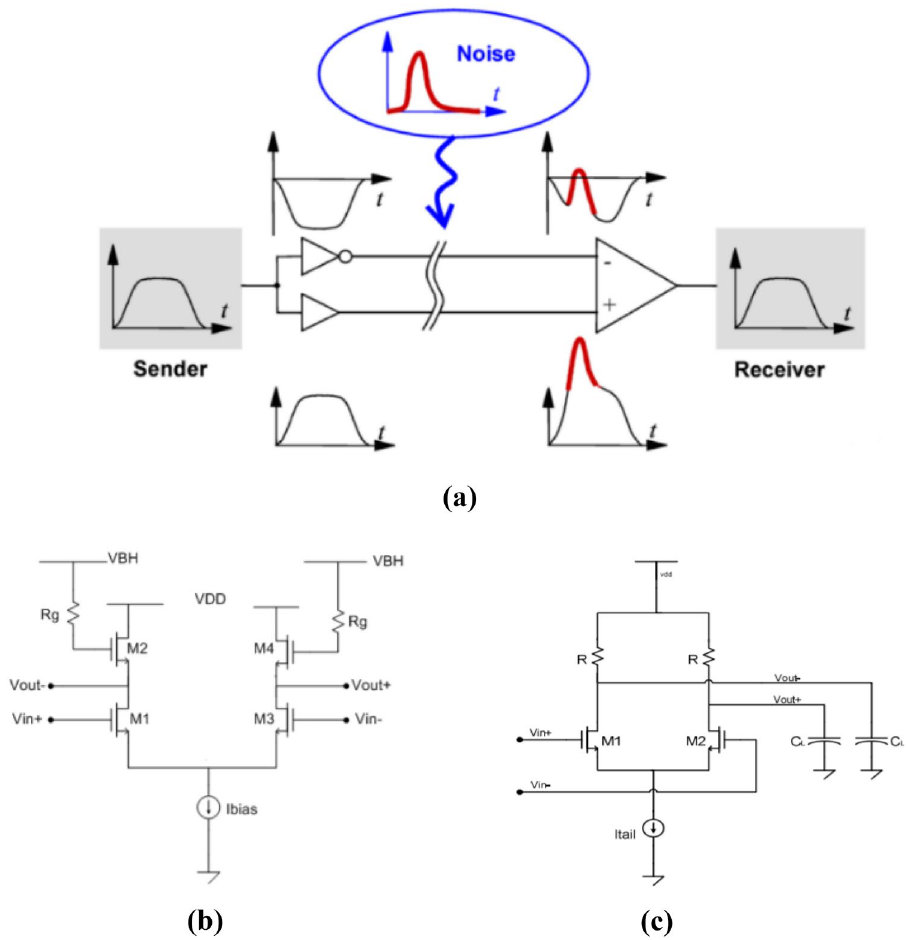
Fig. 3 a Differential signals at the input of op-amp and their noise immunity [26, 27]. b Active-loaded differential amplifier, and (c) Resistive- loaded differential